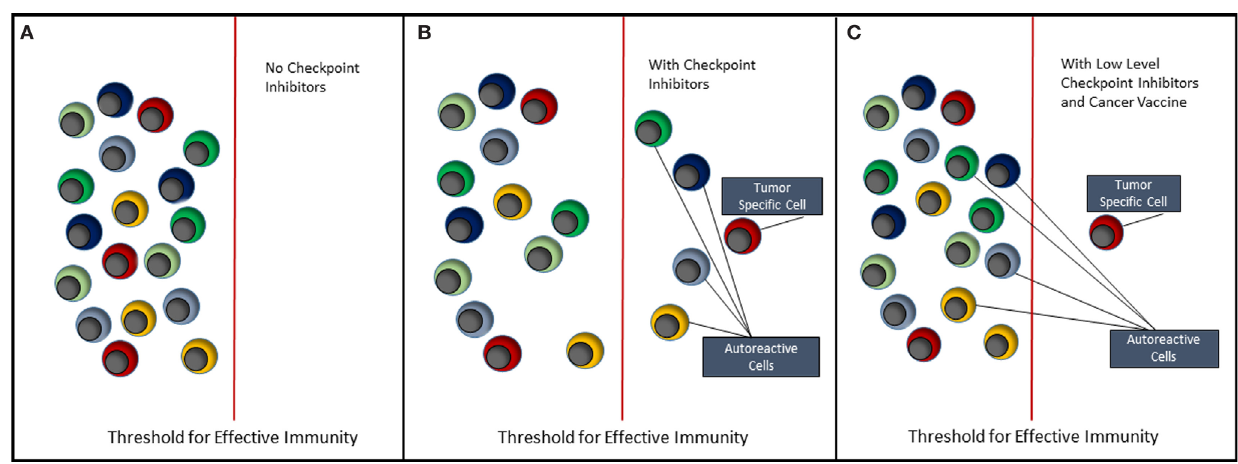
FiGUre 2 | Immunotherapy of cancer. This figure depicts the effect of immunotherapy with checkpoint inhibitors on the immune system. (A) It reflects the steady state in which both tumor-antigen reactive and self-antigen reactive T cells remain quiescent, i.e., in a state of tolerance. (B) When checkpoint inhibitors such as anti-PD-1 and anti-CTLA-4 are administered, both tumor-specific and autoreactive T cells break tolerance, respond to their antigens, clear the tumor, but allow expansion of autoreactive T cells resulting in autoimmune disease. (c) It reflects the situation where either the type of inhibitory receptor targeted by checkpoint inhibitor is changed or the amount of checkpoint inhibitor is reduced to a level that does not trigger autoreactive T cells. It is suggested, however, that coadministration of a selective cancer vaccine will lead to expansion of tumor-specific T cells and hence tumor